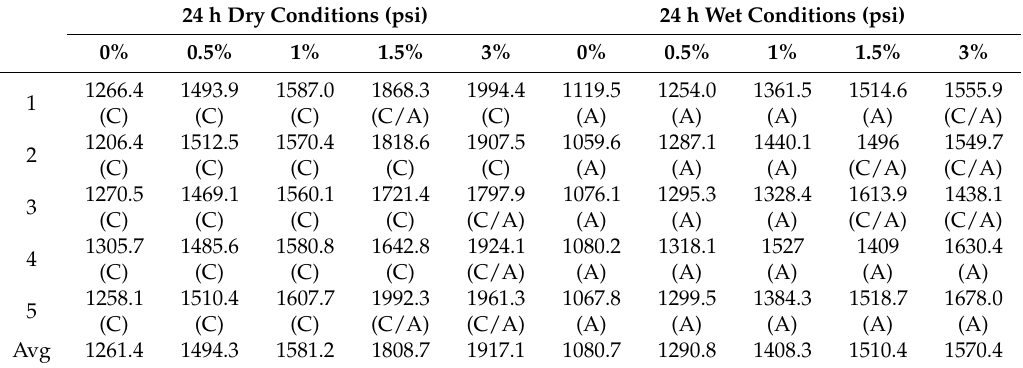
Table 6. POTS (psi) of unmodified and CNT-modified binders and failure pattern.